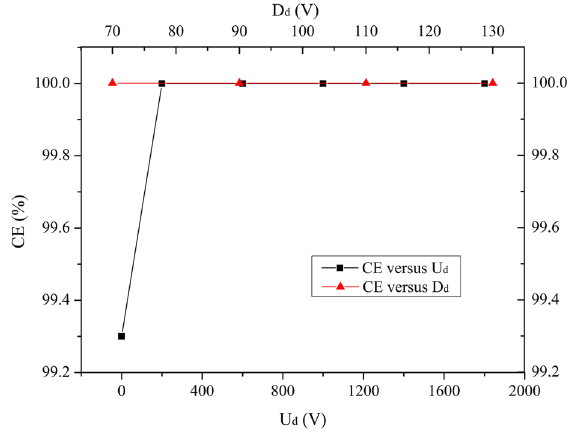
Figure 6. CE versus U d and D d over the ranges of 0 V ≤ U d ≤ 2000 V and 70 mm ≤ D d ≤ 130 mm.